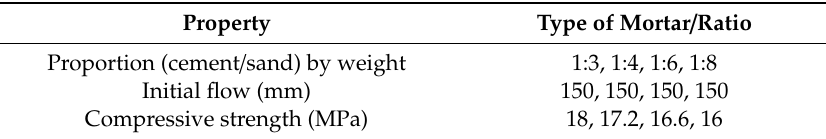
Table 2. Basic properties of